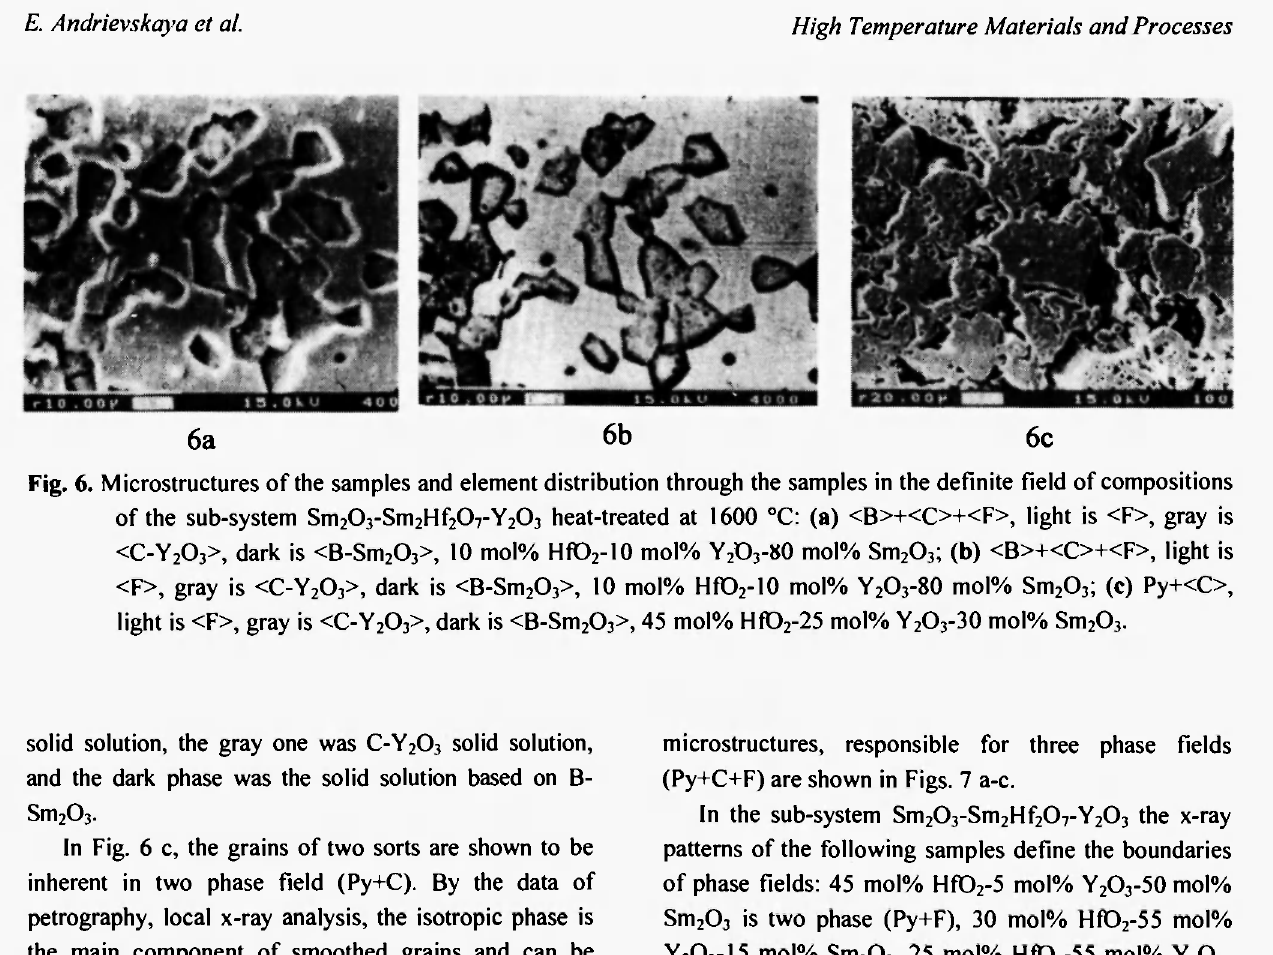
solid solution, the gray one was C-Y 2 0 3 solid solution, and the dark phase was the solid solution based on B- Sm 2 0 3 .